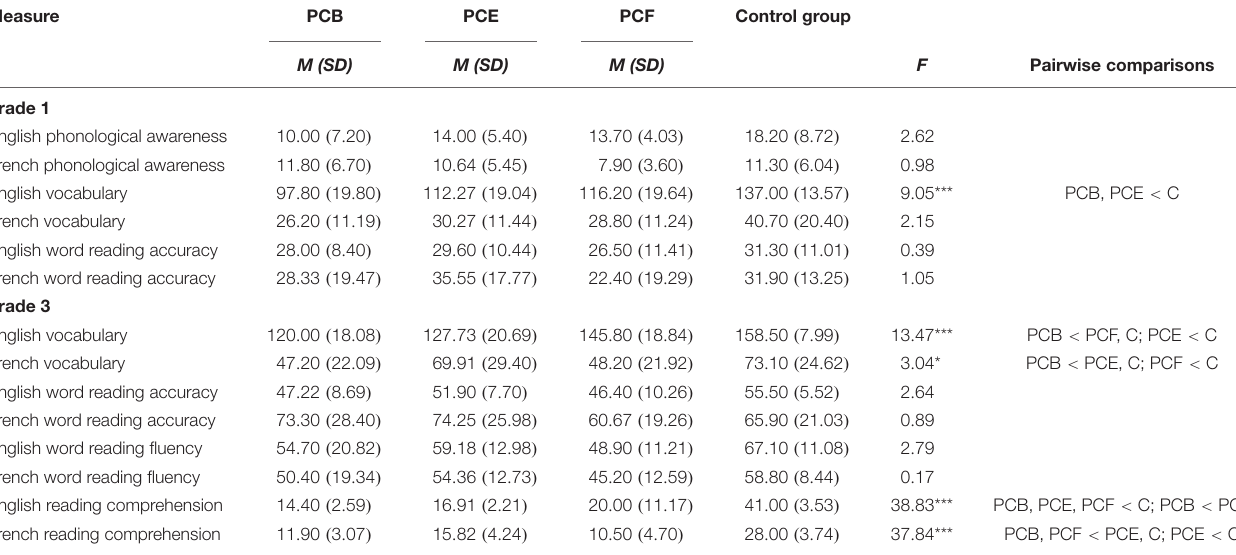
TABLE 5 | Means (standard deviations) and comparisons of poor comprehenders in English and French, poor comprehenders in English only, poor comprehenders in French only, and controls on English and French measures in grade 1 and grade 3.